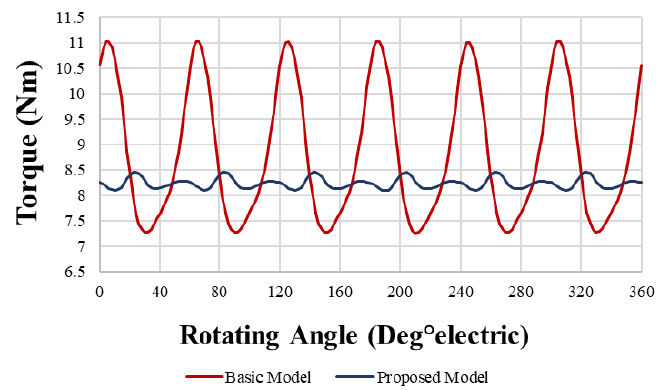
Figure 27. Torque waveform of basic and proposed models.